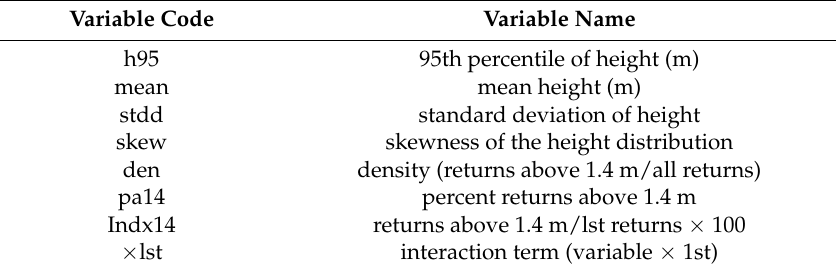
Table 1. LiDAR-derived forest canopy metrics/ T ust explanatory